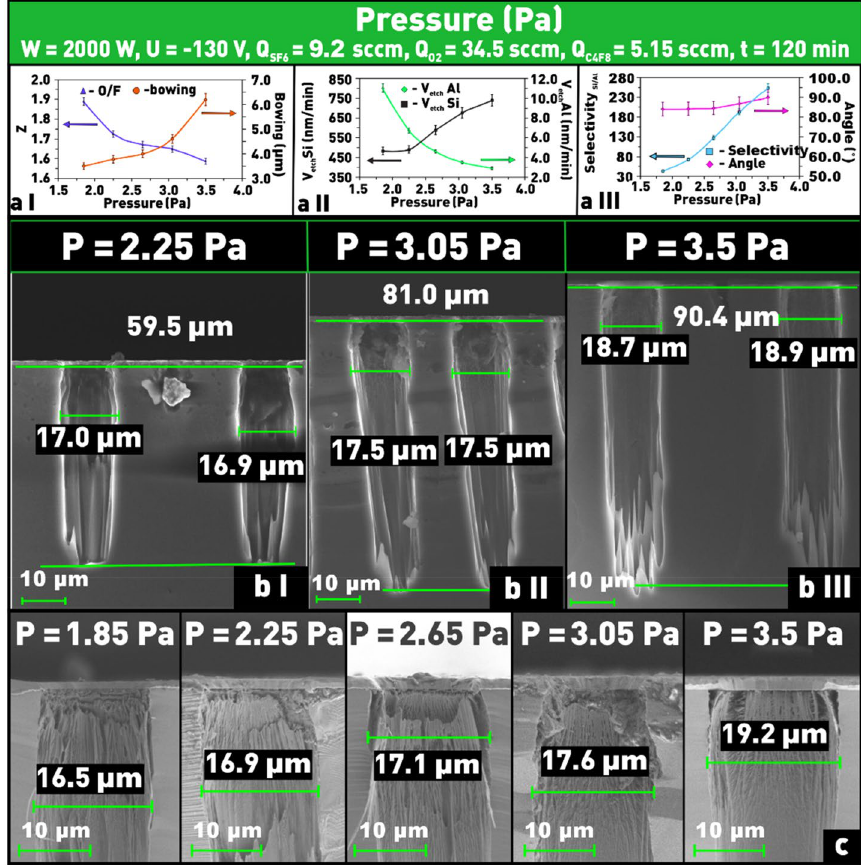
Figure 8. Dependences on pressure in the reaction chamber: ( a I ) of δ and Z; ( a II ) of etching rates of Si and Al; ( a III ) of etch selectivity and angle Θ; ( b I – III ) microphotographs of etch window profiles at different pressures in the reaction chamber; ( c ) microphotographs of etched windows at different values of pressure in SF 6 /C 4 F 8 /O 2 plasma to evaluate the structure overetching